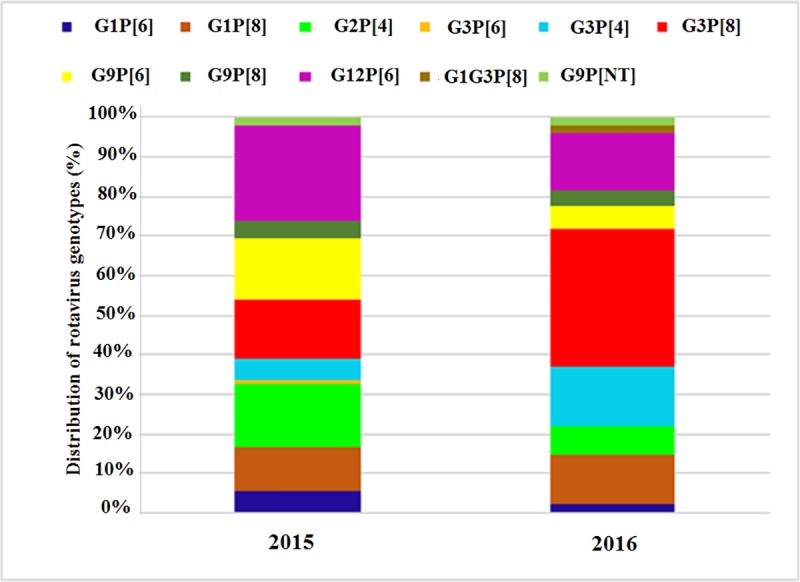
Distribution of RVA G/P genotype combinations in 2015–2016.